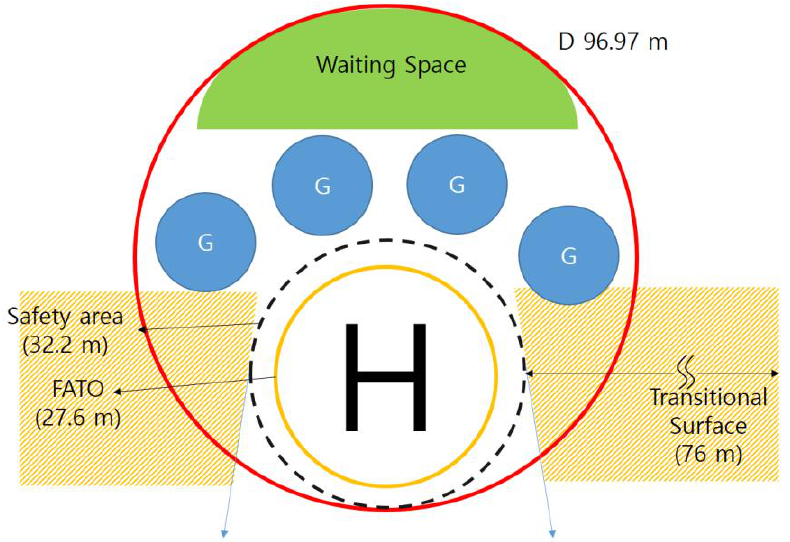
Figure 12. Example of satellite topology that complies with the EASA’s new regulation.